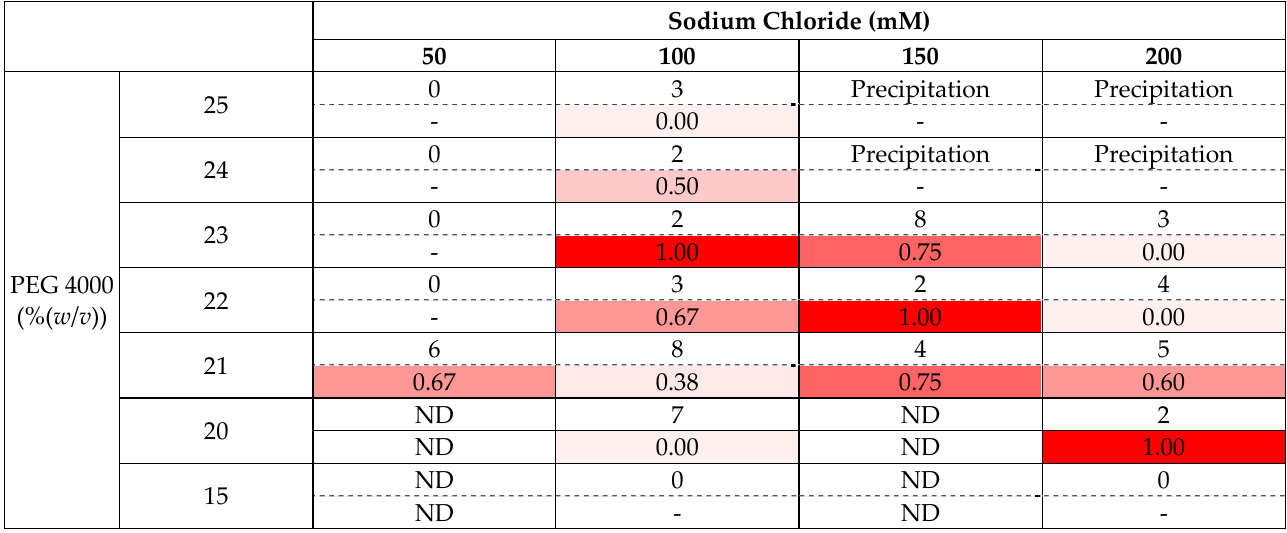
Table 5. Number of crystals in unit volume and the ratio of single crystals of alpha-amylase grown by microbatch crystallization in sodium chloride and PEG 4000. The table shows the number of crystals per unit volume (1 µ L) (top number) and the ratio of single crystals to all crystals (bottom number) ten days after crystallization setup.